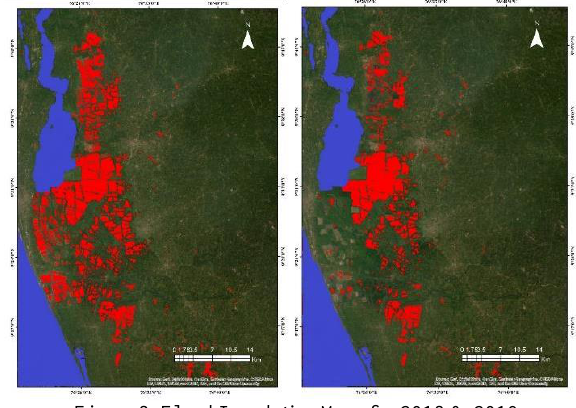
Figure 8. Flood Inundation Map for 2018 &